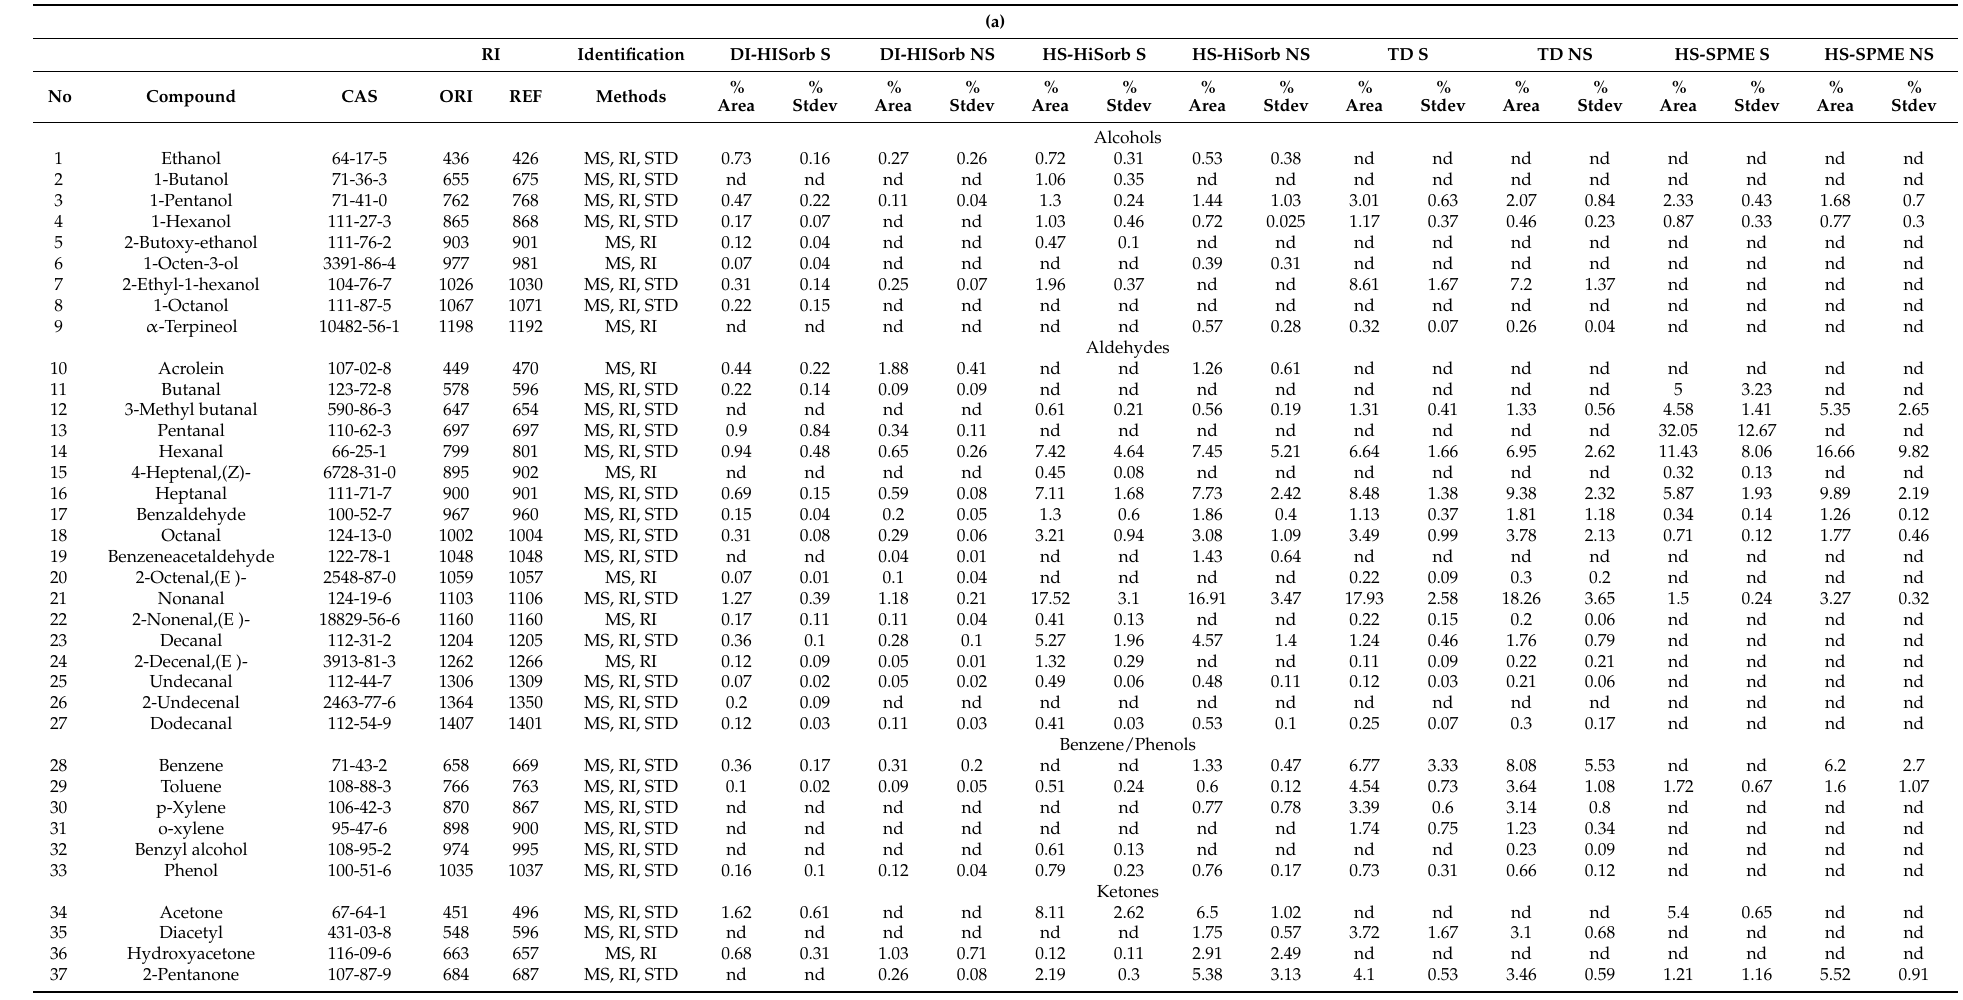
Table 2. ( a ) Identification of volatile compounds by each extraction technique with and without salting out using the non-polar GC column. ( b ) Identification of volatile compounds by each extraction technique with and without salting out using the polar GC